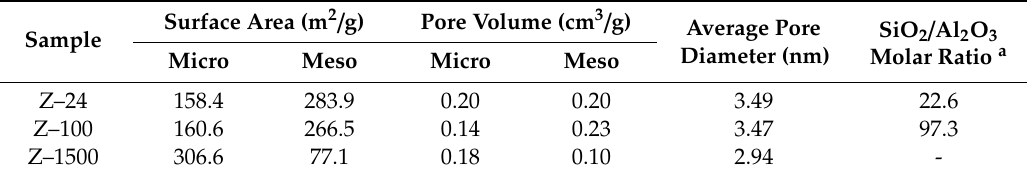
Table 2. The physical properties of di ff erent catalysts.